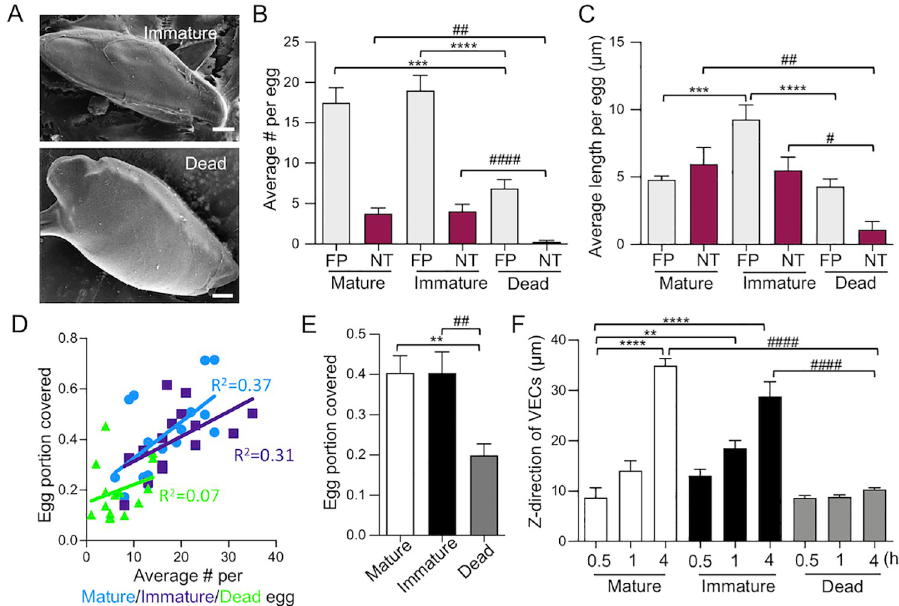
Fig 3. Encapsulation of S . mansoni eggs by VEC filopodia depends on egg vitality. (A) SEM images of VECs encapsulating a live immature egg and a dead mature egg after 4 h (scale bar: 10 μ m). (B) Number of FPs and NTs per egg (mean ± s.e.m.). ��� and ���� indicate p < 0.001 and p < 0.0001 when comparing FPs. ## and #### indicate p < 0.01 and p < 0.0001 when comparing NTs. (C) Length of FP and NTs per egg (mean ± s.e.m.). ��� and ���� indicate p < 0.001 and p < 0.0001 when comparing FPs. # and ## indicate p < 0.05 and p < 0.01 when comparing NTs. For B and C , a one-way ANOVA with Tukey’s post-test was used. (D) The portion of eggs covered by VECs as a function of the average number of FPs per egg at 4 h. Mature (light blue circles) and immature live eggs (purple squares) show significant Pearson correlations which p value = 0.012 and 0.029, respectively), whereas dead eggs do not (p = 0.075). (E) Portion of live mature (white), immature (black) and dead (gray) eggs covered by VECs after 4 h. �� indicates p < 0.01 and ## indicates p < 0.01 using a one-way ANOVA with Tukey’s post-test. For A – E , a total of 16, 15 and 14 live mature, live immature and dead eggs from three independent experiments were analyzed. (F) Quantification of the encapsulation dynamics as a function of the maximum height (z-direction; mean ± s.e.m.) reached by VECs at different time points. �� and ���� indicate p < 0.01 and p < 0.0001, respectively, using a one-way ANOVA with Dunnett’s post-test. #### indicates p < 0.0001 when comparing 4 h mature, immature and dead eggs, using a one-way ANOVA with Tukey’s post-test. Across three independent experiments, 7–12 eggs were analyzed for each condition.